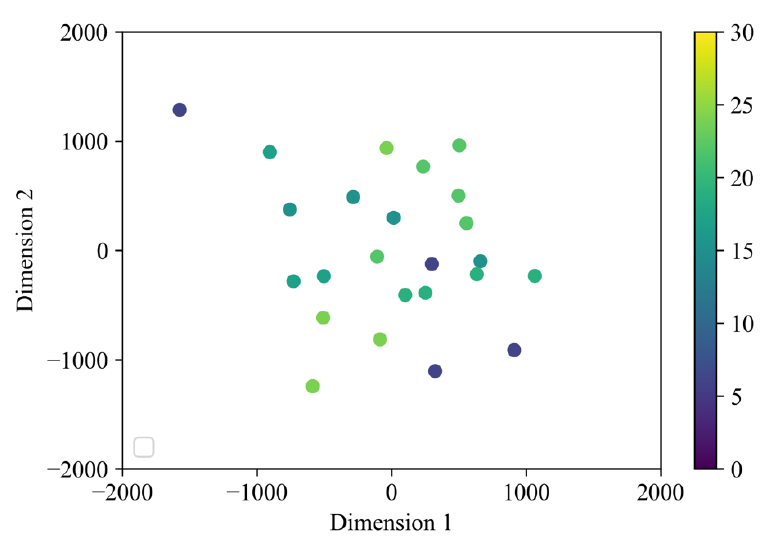
Figure 9. Standing behavior map categorized by MMSE.